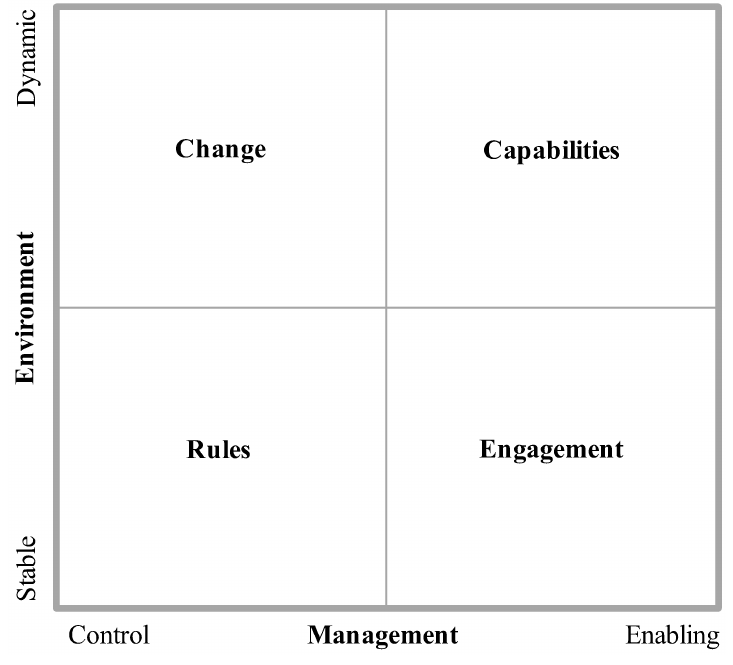
Figure 1. The context